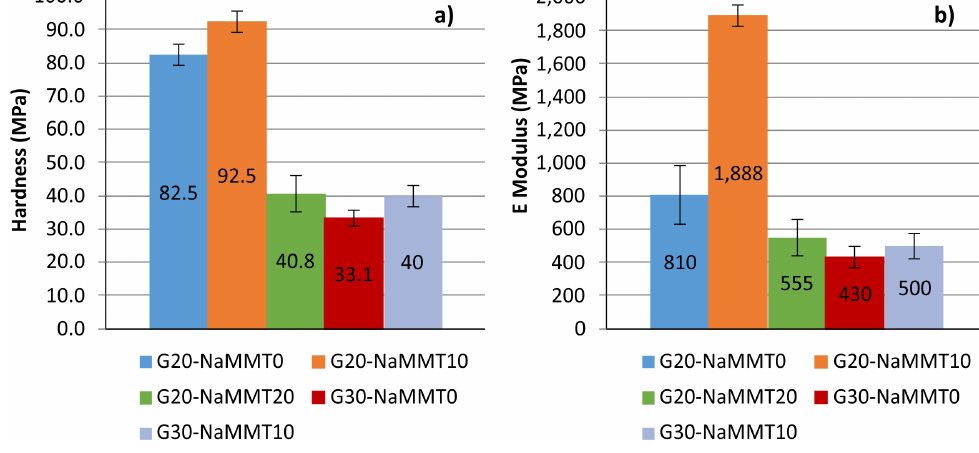
Figure 8. Hardness and modulus of elasticity from nanoindentation